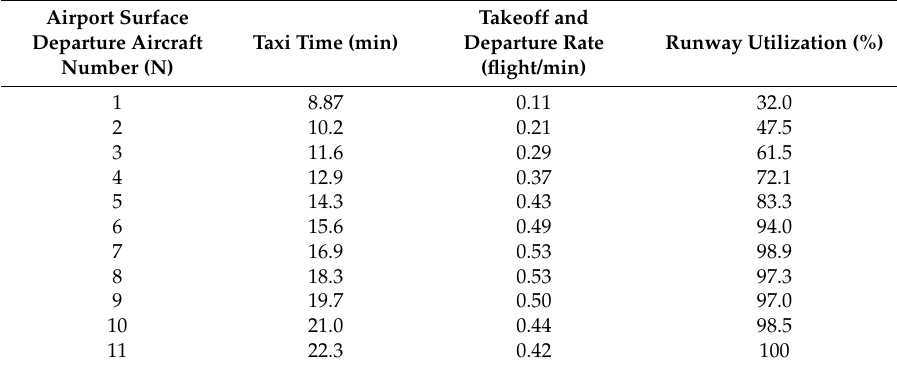
Table 4. The operating parameters for different numbers of departure